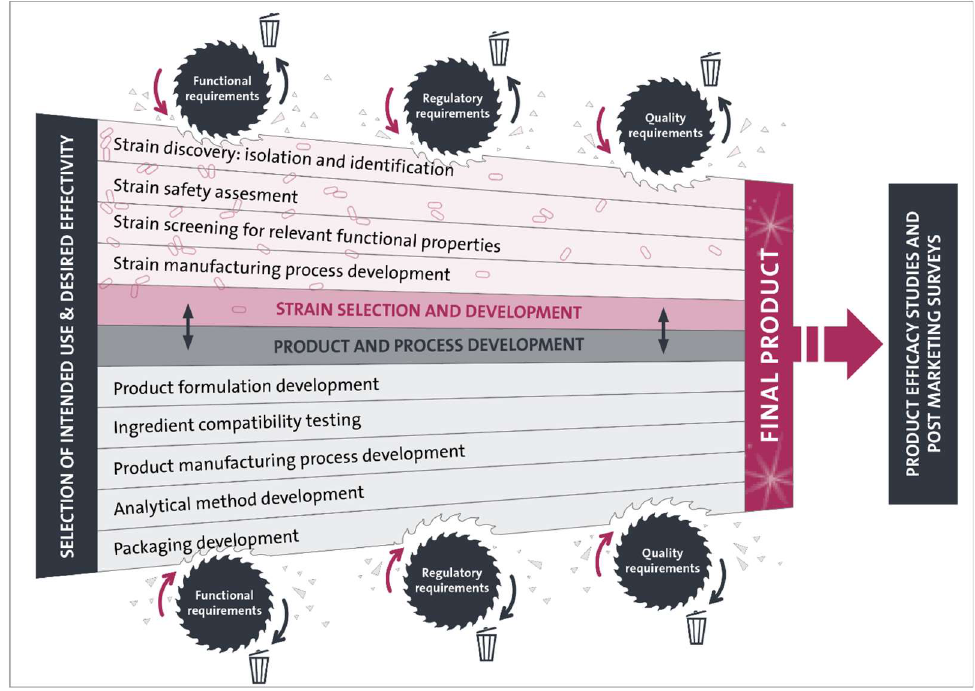
Figure 1. Schematic overview of the multidisciplinary approach that is needed for the development of an evidence-based, indication-specific, multispecies and ready-to-market probiotic. All the steps needed for strain and product development are shaped by the functional, regulatory and quality requirements of the final product. During this process, several candidates (of strains, additives, production process blueprints, and packaging ideas) get discarded. In addition, manufacturing processes are finetuned and analytical methods need to be developed to guarantee consistent efficacy and safety of a finished probiotic product. Strain and product development is followed by product efficacy studies and post-marketing surveys in order to demonstrate clinical efficacy of the finished probiotic product.